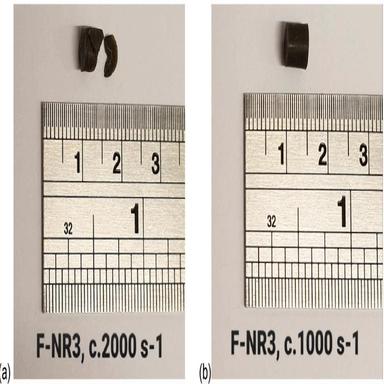
Post-mortem examination for high strain rate experiments at − 60 ◦C for F-NR3 at (a) c. 1000 s − 1 and (b) c. 2000 s − 1 .